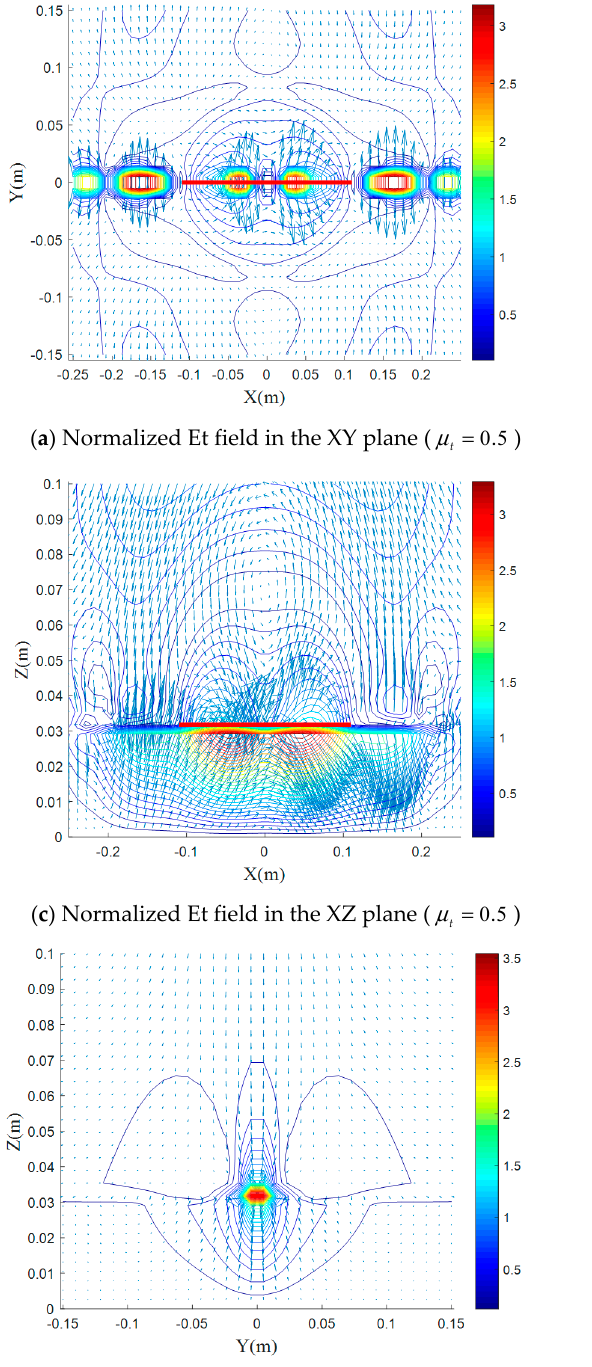
μ with 253 . == εε and 1 = μ , in the XY, t tz z